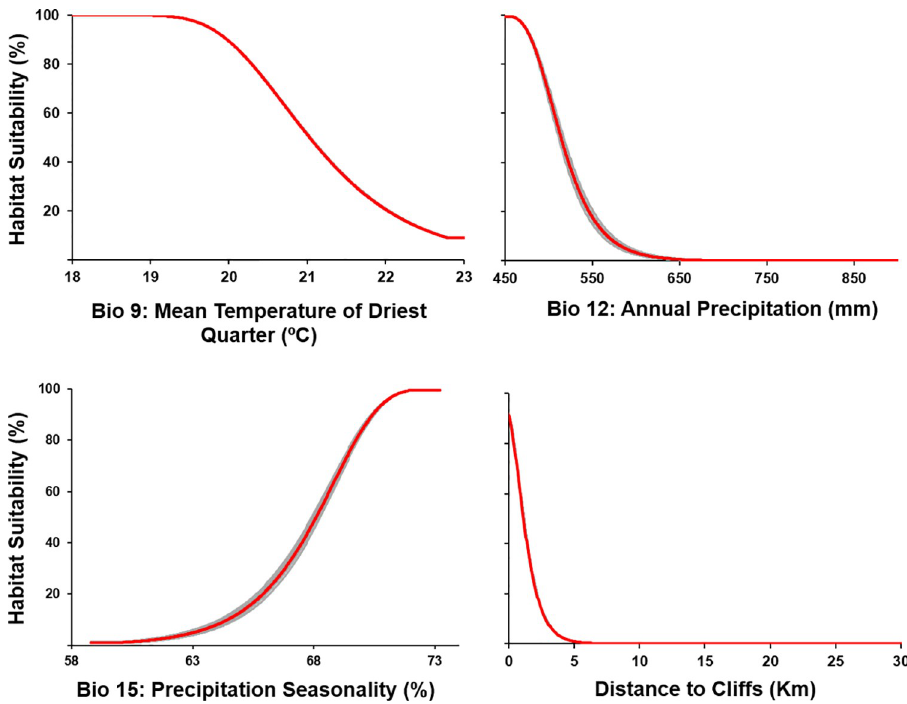
Fig 4. Response curves for each environmental variable. Plots resulting from the models created using only the corresponding variable. The grey colour represents cross-validation replications and the red colour represents the average of those ten